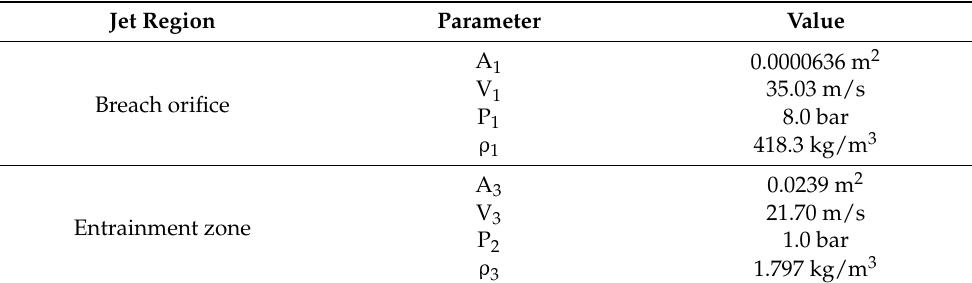
Table 1. Leak parameter before and after leak model application.